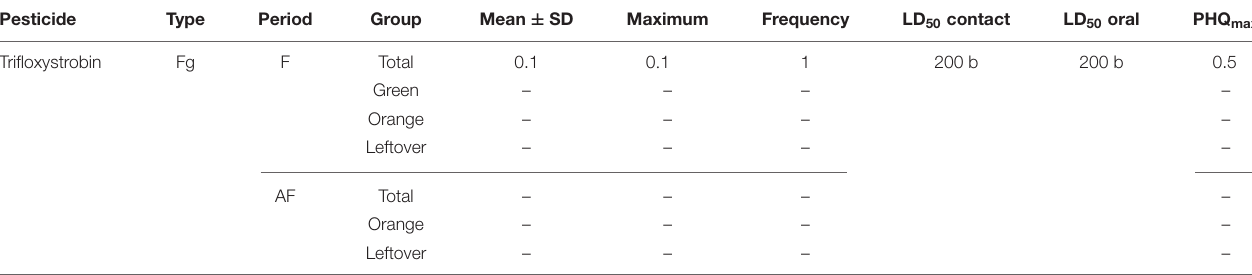
TABLE 5 | Number of pesticides detected in pollen samples from different color group, during and after apple blossom, for each location. Location